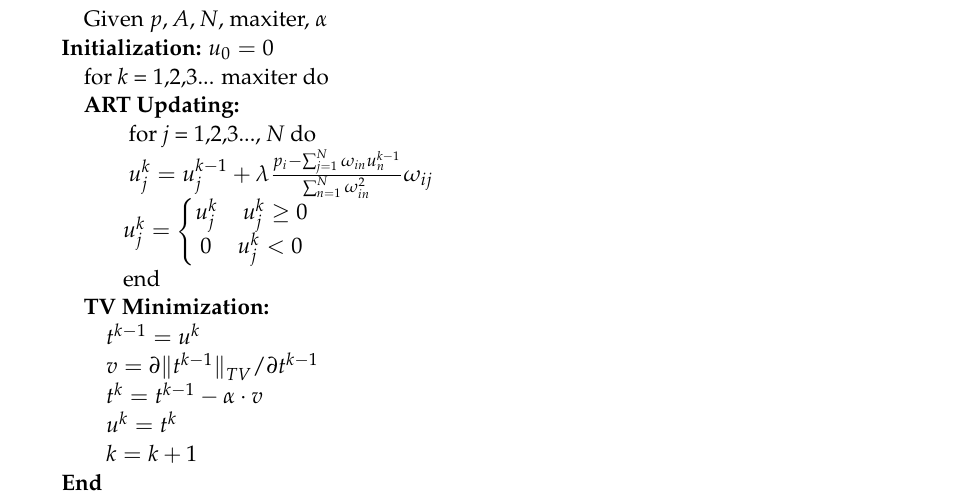
Algorithm 1: Implementation of TV sparse reconstruction with ART model.